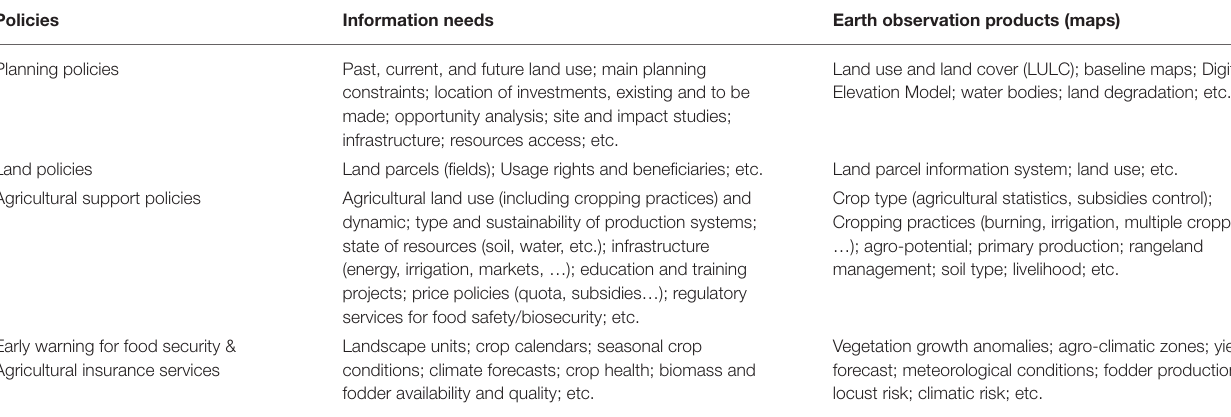
TABLE 1 | What information and what EO products, for what policy? [adapted from Bégué et al. (2016)]. Policies Information needs Earth observation products